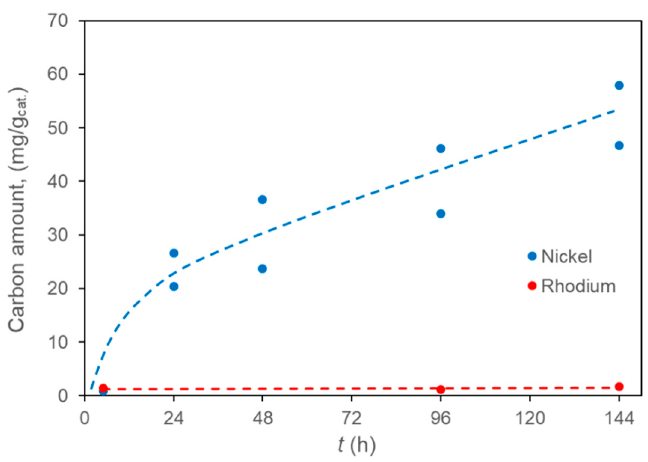
Figure 6. Effect of reaction time on carbon formation for nickel and rhodium catalysts. The first 5 h point is with Gas1 for both catalysts; the other points with Gas2. Reaction conditions for 5 h points: atmospheric pressure, 900 °C, 20,000 vol-ppm ethylene and gas composition 1. Reaction conditions for 24–144 h points: atmospheric pressure, 950 °C, 24,500 vol-ppm ethylene and gas composition 2.